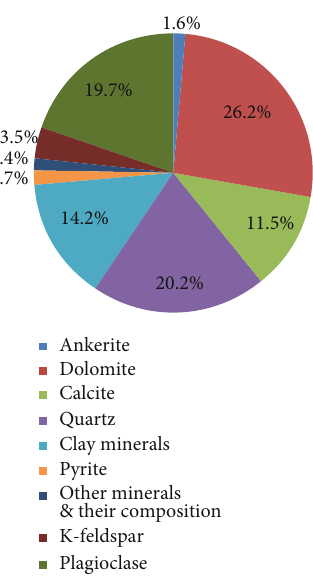
Figure 2: Mineral composition fan chart of Lucaogou